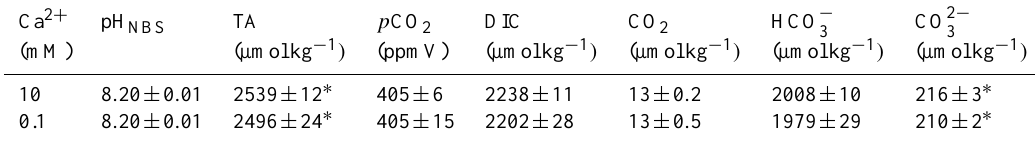
Table 1. Parameters of the artificial seawater carbonate system at the ambient (10mM) and reduced (0.1mM) levels of Ca 2 + equilibrated with ambient CO 2 (39.3Pa). Total alkalinity, pH, salinity, nutrient concentration and temperature were used to derive all other parameters using a CO 2 system analyzing software (CO 2 sys). Data are the means ± SD of 3 measurements. The asterisks denote significant difference between the two Ca 2 + concentrations.